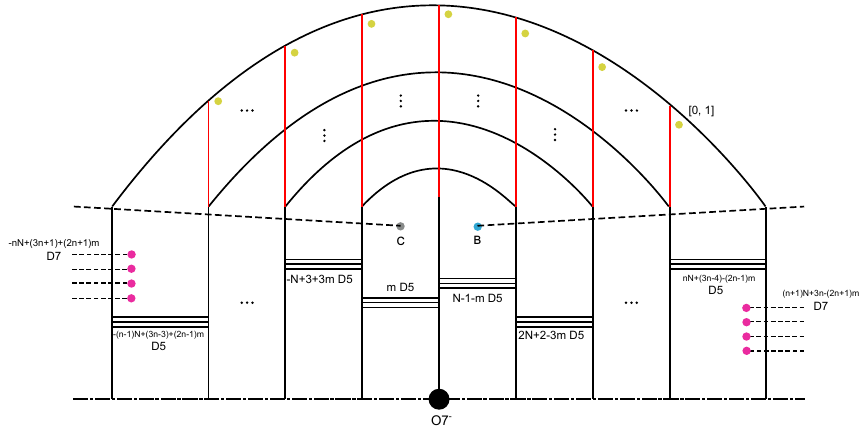
Figure 38 . The diagram for the case where only one of the two O 7 node, the extra color D5-branes reduce by two and there are only two additional color D5 branes at the columns at the both